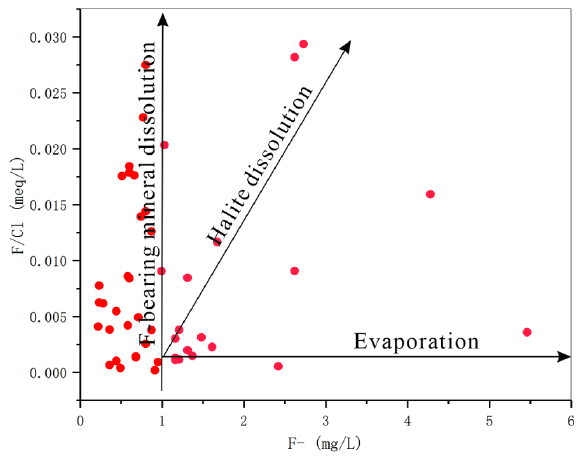
Figure 5. Relationship between the ρ [F − ] and the [F − ]/[Cl − ] ratio.